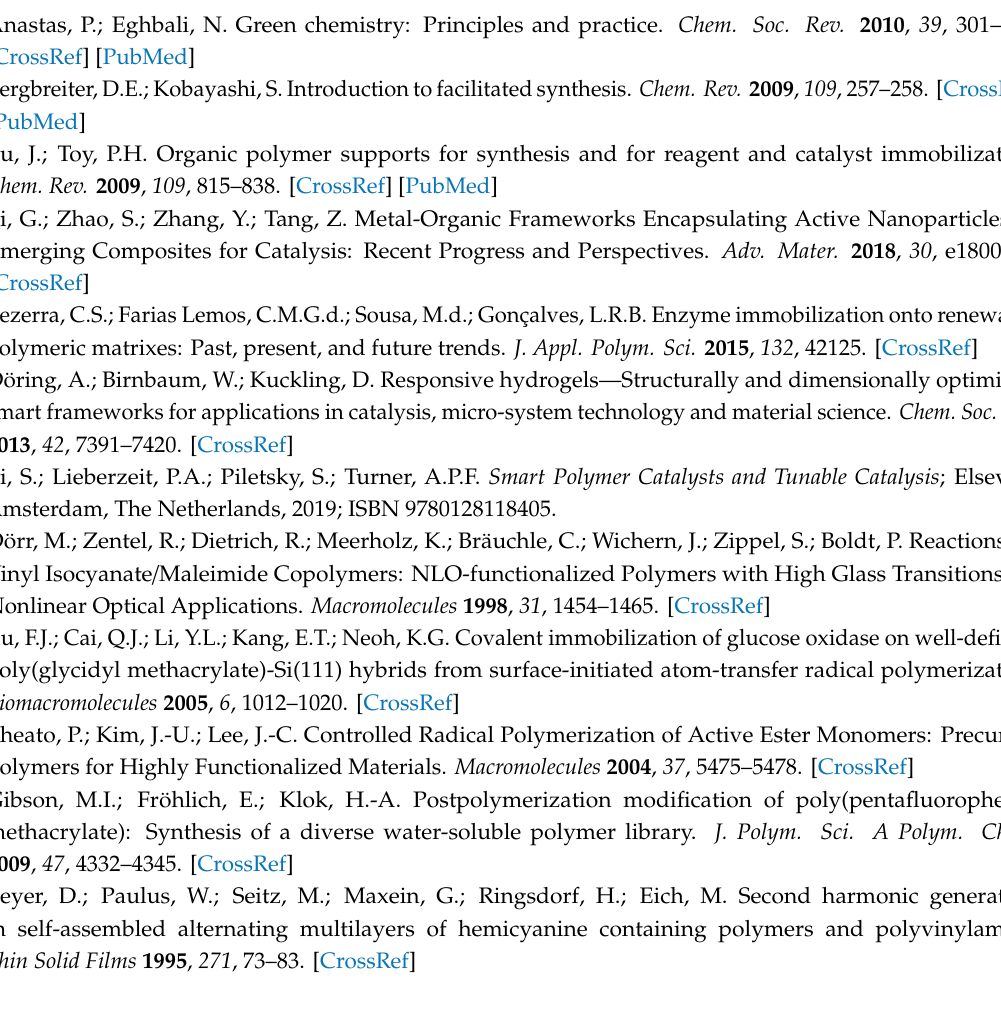
Figure S1: Normalized molar mass distributions of the azlactone-containing block copolymers (SEC in THF, PMMA calibration); Figure S2: 1 H-NMR spectrum of the functionalized block copolymer POC 1 (characteristic peaks are labelled, integrated and assigned); recorded at 500 MHz in DMSO-d6; Figure S3: 1 H-NMR spectrum of the functionalized block copolymer POC 2 (characteristic peaks are labelled, integrated and assigned); recorded at 500 MHz in DMSO-d6; Figure S4: 1 H-NMR spectrum of the functionalized block copolymer POC 3 (characteristic peaks are labelled, integrated and assigned); recorded at 500 MHz in DMSO-d6; Figure S5: UV / VIS spectra of the DMP RAFT agent and the PDMAAm- b -P(NIPAAm- co -VDMA) block copolymer before and after attachment of the prolineamide organoctatalyst (solvent: